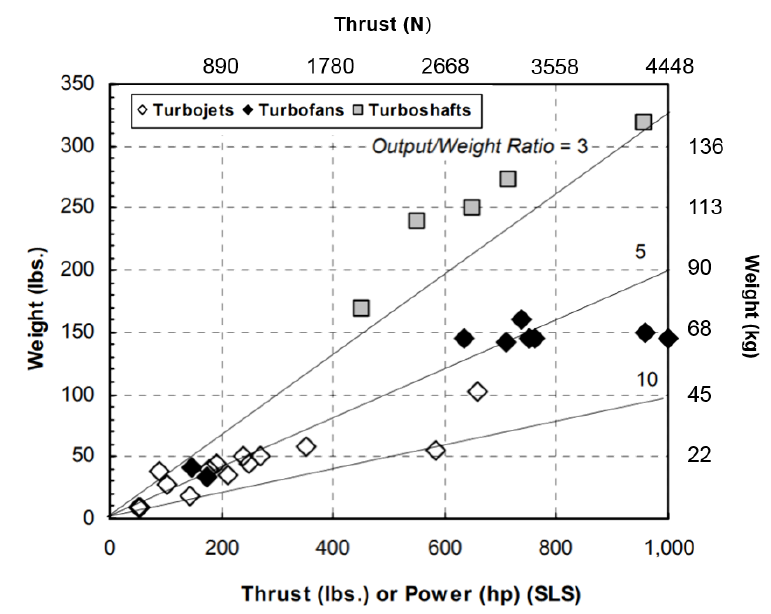
Figure 1. Existing gas turbine engines under 1000 lbs of thrust.